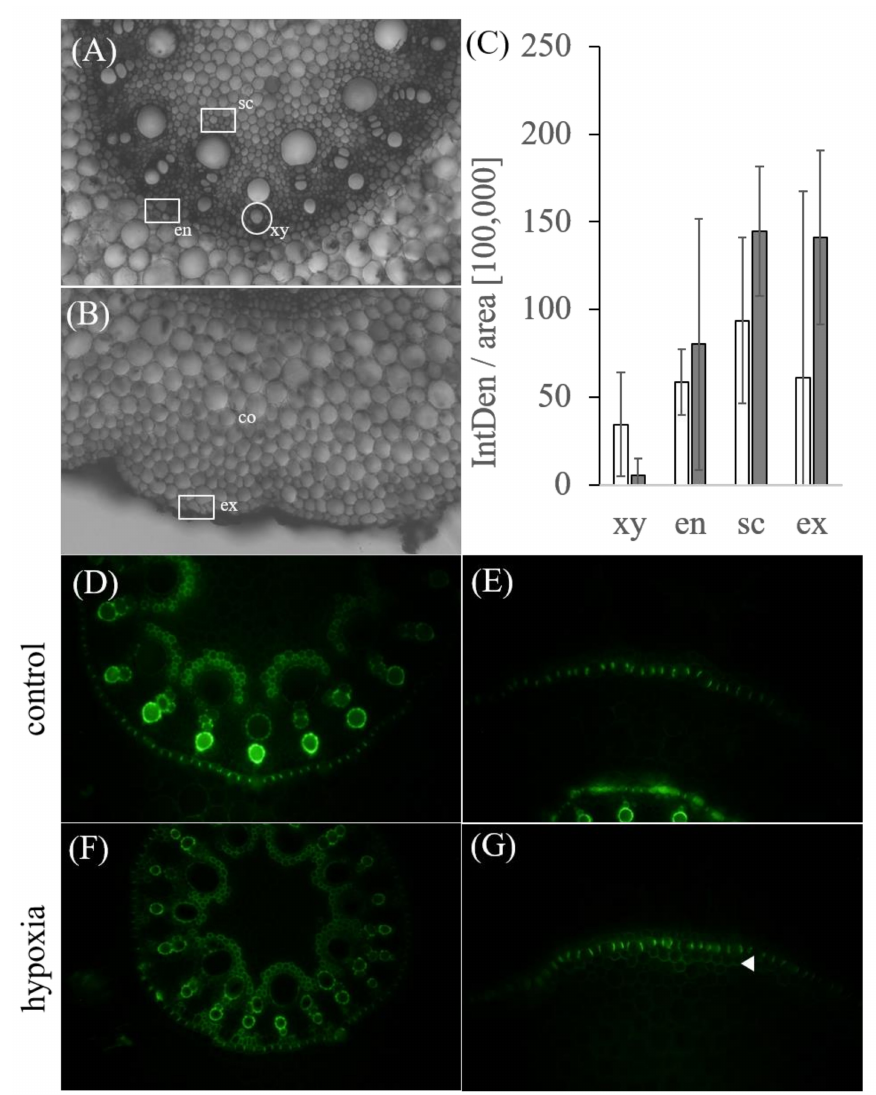
Figure 8. Visualization of suberin in the mature zone of primary root cross-sections from control and hypoxia-stressed maize plants. Control and 24 h hypoxia-stressed maize roots were cross-sectioned by hand and stained with the fluorescent berberine–aniline blue to detect suberin. Images were taken with 10x magnification using an Olympus BHS fluorescent microscope. ( A , D , F ) Shown is an overview of the central cylinder with vascular bundles and ( B , E , F ) the cortex and exodermis of maize root transversal section in brightfield image ( A , B ) and fluorescent image ( D – G ). (G) White arrow indicates an additional suberin layer beneath the exodermis in stressed samples. ( C ) Intensity measurements of endodermis (en), exodermis (ex), vascular sclerenchyma cells (sc) and xylem vessels (xy) were calculated as intensity per area (IntDen / area) for controls (white columns) and stressed samples (grey columns). Error bars indicate standard deviation for three to five biological